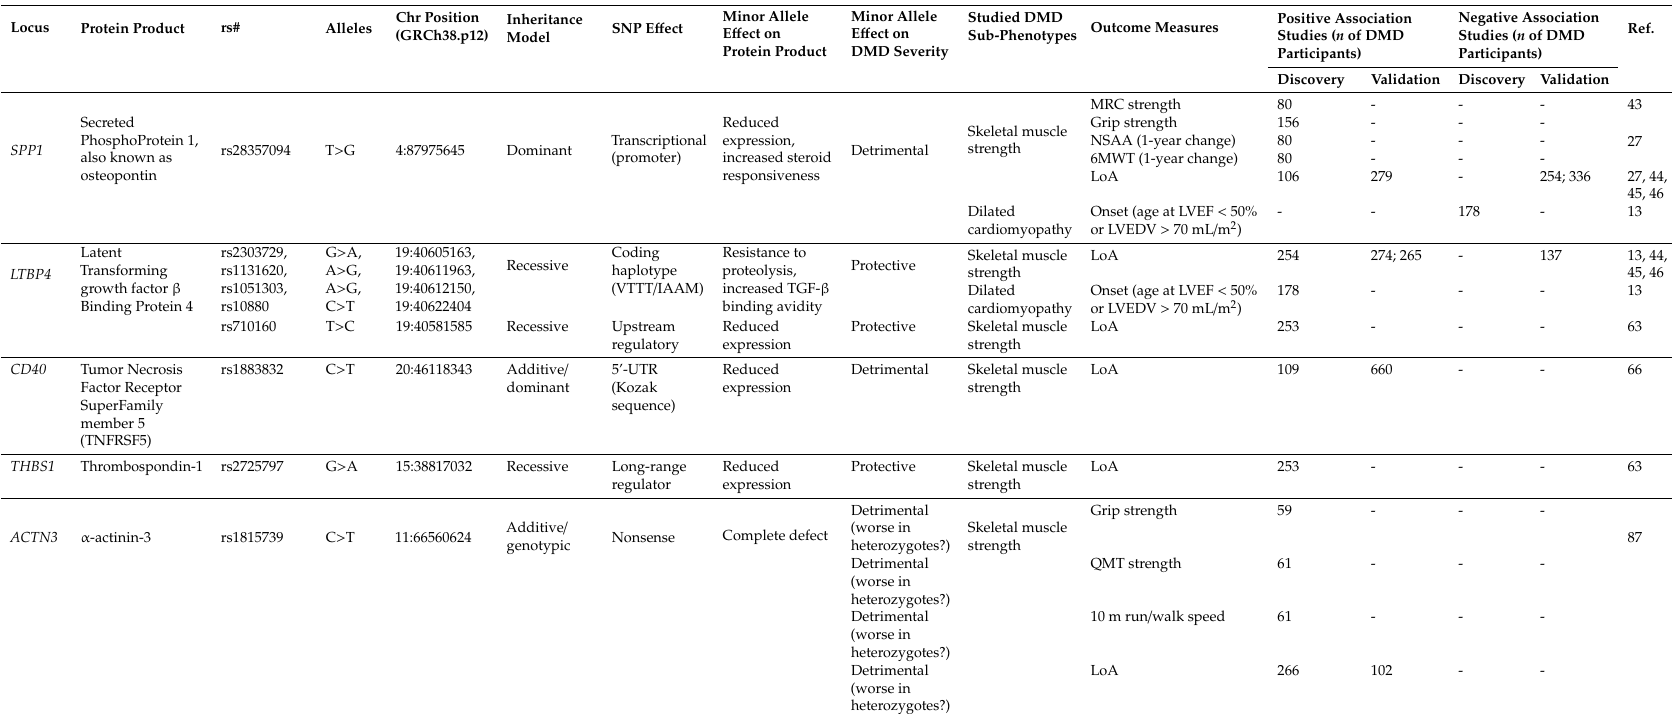
DMD: Duchenne muscular dystrophy. SNP: single nucleotide polymorphisms. Chr: chromosome. MRC: Medical Research Council manual muscle testing score. NSAA: North Star Ambulatory Assessment. 6MWT: 6 Minute Walk Test. LoA: loss of independent ambulation. LVEF: left ventricle ejection fraction. LVEDV: left ventricle end diastolic volume. 5’-UTR: 5’ untranslated region. QMT: quantitative muscle